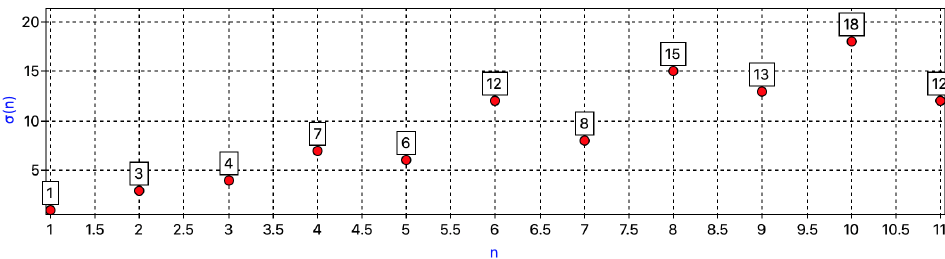
Figure 4. The simulation for σ ( n ) with 1 ≤ n ≤